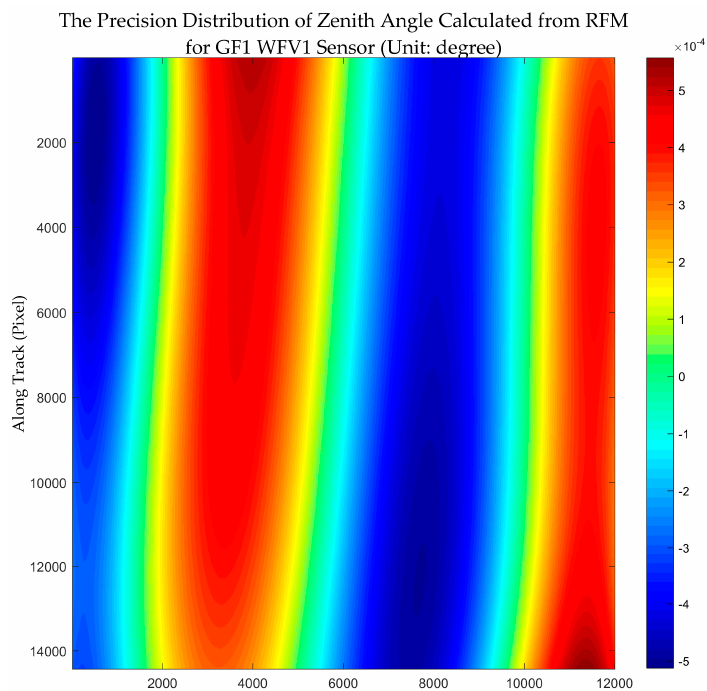
Figure 6. Precision distribution for the zenith angle calculated from the Rational Function Model (RFM) for Gaofen-1 (GF-1) Wide-Field-View-1 (WFV-1) sensor (unit: degrees).